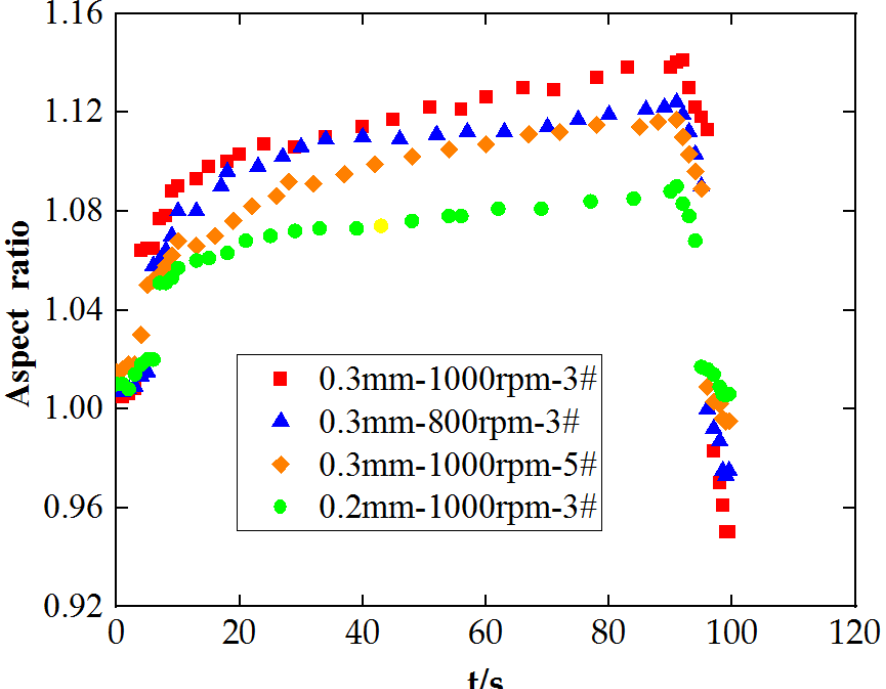
Figure 4. The experimentally observed change in the aspect ratio of the droplet for different conditions ( a = 1.061 mm/rad).